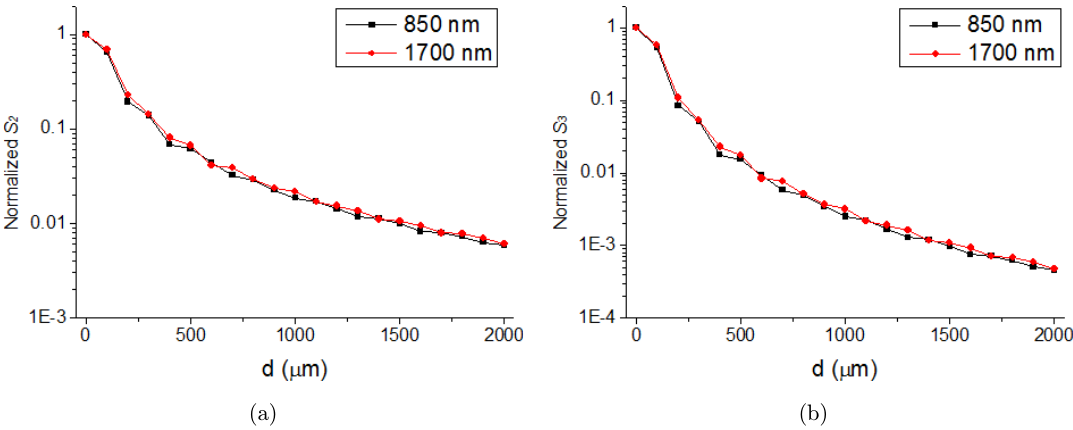
Fig. 3. (a) Normalized (a) S 2 and (b) S 3 vs imaging depth for 850-nm and 1700-nm excitations. S 2 and S 3 were normalized to those at the surface ( d ¼ 0). Also NA ¼ 1 : 05 and n 1 ¼ 1 : 33; (cid:2) n ¼ 0 : 03 for 850-nm excitation and (cid:2) n ¼ 0 : 06 for 1700-nm excitation.